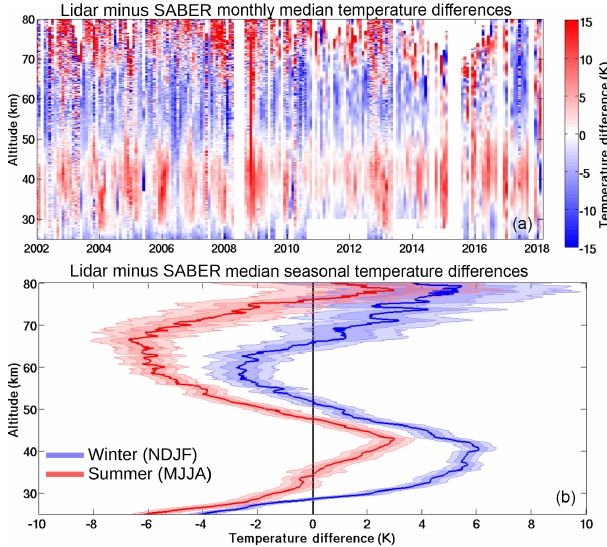
Figure 3. The 16-year systematic comparison of OHP lidars and SABER temperatures. The monthly median temperature differences between the lidar and SABER are shown in panel (a) . Red indi- cates that the lidar is warmer than SABER and blue that the lidar is colder. There are 1100 nights of coincident measurements in the colour plot. Panel (b) is a seasonal ensemble of lidar minus SABER temperature differences. The summer (May, June, July, August) en- semble in red includes 306 nights of coincident measurements, and the winter (November, December, January, February) ensemble in blue includes 397 nights of coincident measurements. Shaded errors represent 1 and 2 standard